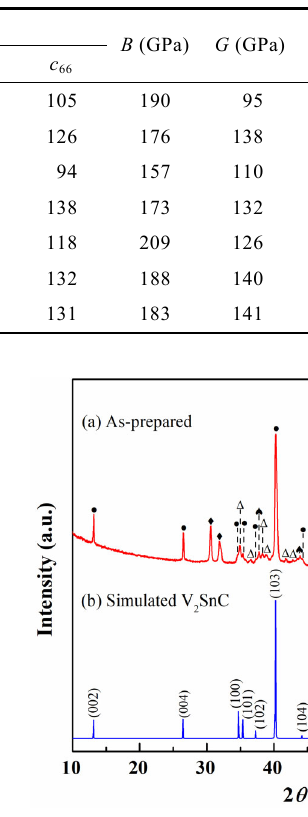
Theoretically predicted c ij , bulk modulus ( B ), shear modulus ( G ), Young’s modulus ( E ), Poisson’s ratio ( v ), and Pugh’s ratio ( G / B ) for V 2 SnC, Ti 2 SnC, Zr 2 SnC, Hf 2 SnC, Nb 2 SnC, Cr 2 AlC, and Ti 3 SiC 2